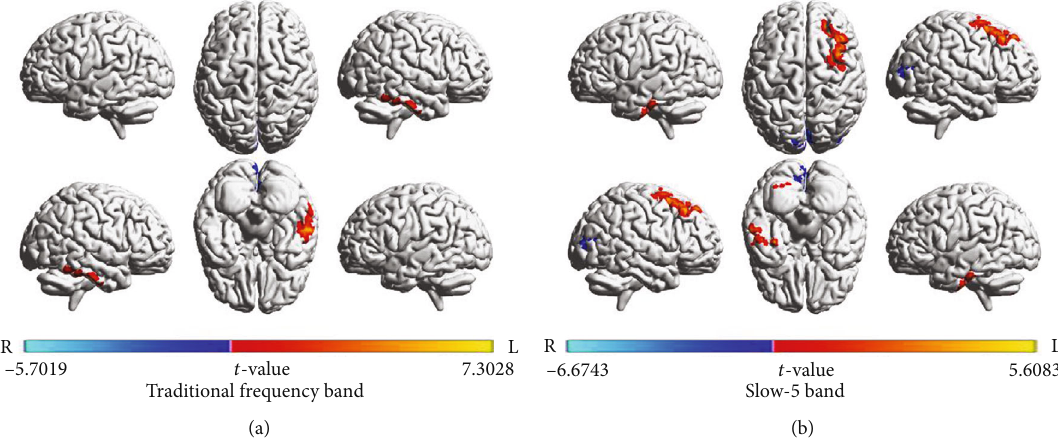
Figure 3: Di ff erence of brain regions in three frequency bands between patients before treatment and HCs. Table 4: The mfALFF values of these clusters were extracted for every participant and compared between each pair of the three groups in traditional